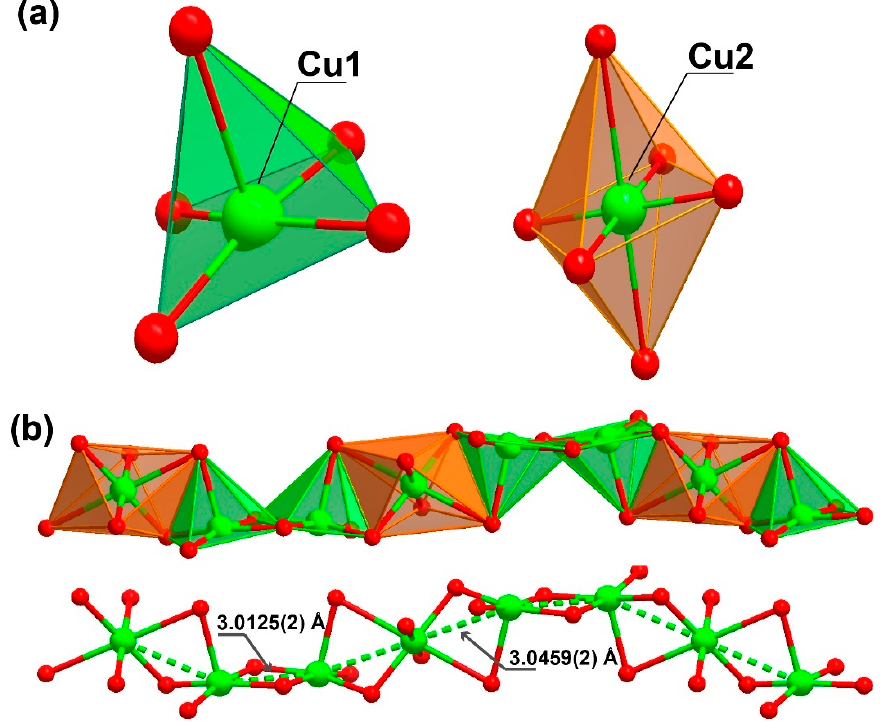
Figure 2. Representation of the ( a ) coordination environment present for the two crystallographically independent Cu 2+ cations, exhibiting a square pyramid and a octahedral coordination sphere (for Cu1 and Cu2, respectively) and ( b ) the inorganic chain with a “ABBA” connectivity between the metal centres extending along the (011) plane present in [Cu 3 L 2 (DMF) 2 ] n ( 1 ).